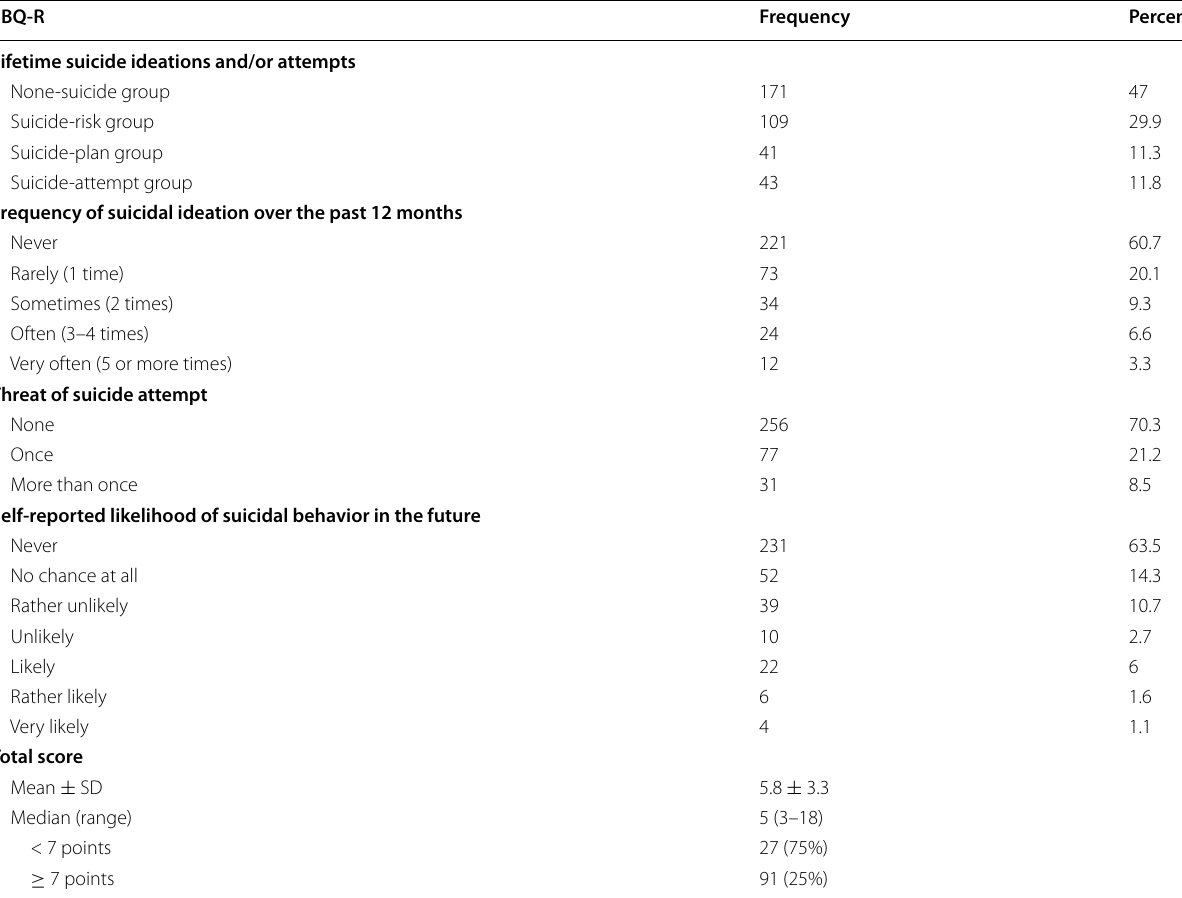
Table 1 Total scores of suicidal behaviors as reported by the studied youth ( n